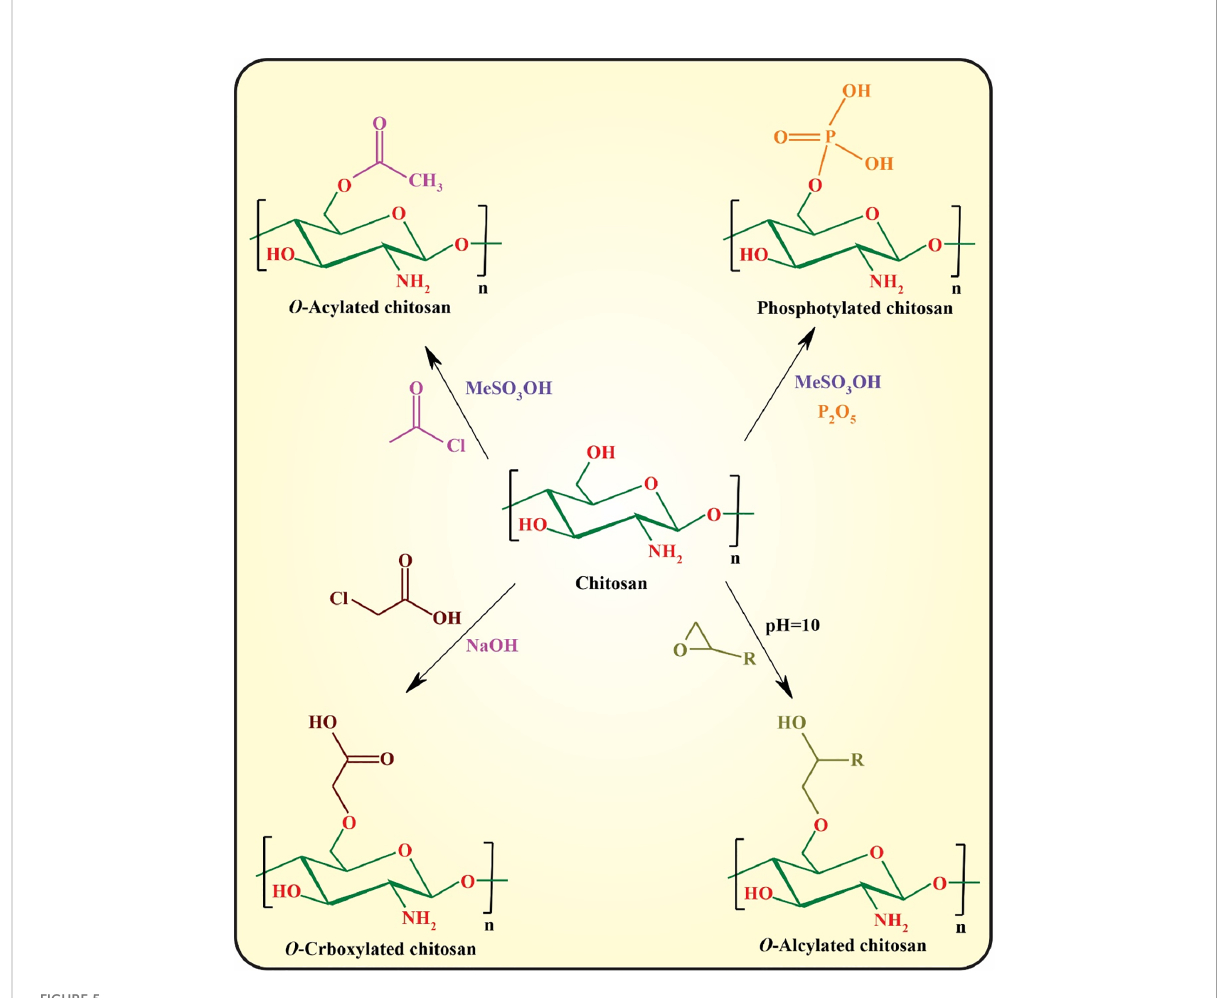
FIGURE 5 N -substitution of chitosan by different